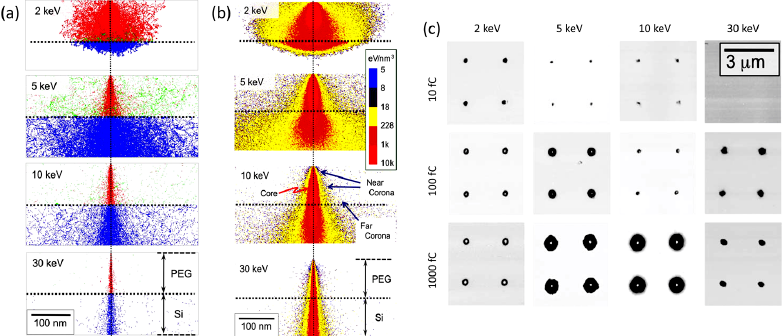
Figure 2. ( a ) Monte Carlo simulation describing the trajectory of 1000 electrons with energies of 2, 5, 10, or 30 keV across a 100 nm thick solvent-free polyethylene glycol (PEG) resist on a Si substrate; primary electrons of the beam are represented in red, scattered electrons in blue, backscattered electrons in green. ( b ) Distribution of deposited energy ( c ). Phase-contrast atomic force microscopy (AFM) images of PEG microgels patterned on silanized Si surfaces with different incident electron energies and different point doses. Based on [30]. Primary electrons (red) that pass through the resist into the underlaying Si layer are scattered to higher angles (blue). Backscattered electrons (green) originate from both me-